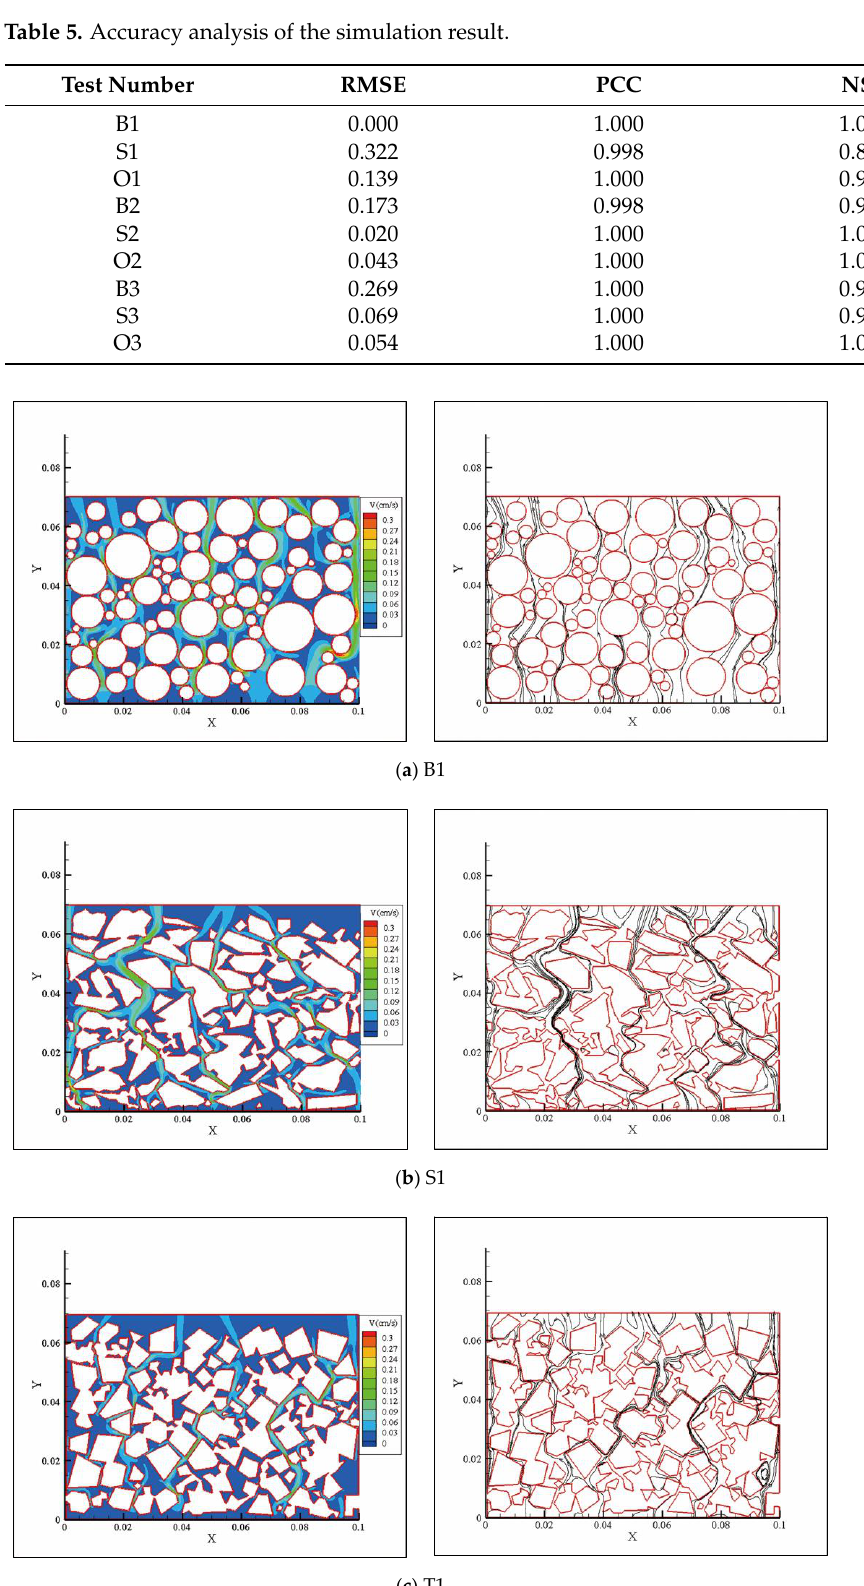
Figure 19. Partial flow field diagrams obtained from the simulation. The left column graphs are the velocity field diagrams with a hydraulic gradient of 0.1, and the right column graphs are the streamline diagrams with a velocity greater than 0.09 cm/s, flowing from the inlet to the outlet with the same hydraulic gradient.